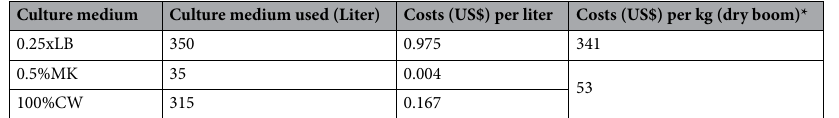
Table 3. Comparison of costs for bioboom production. *30 THB is equivalent to 1 US$. **Himedia™ Luria Bertani Broth (Miller).